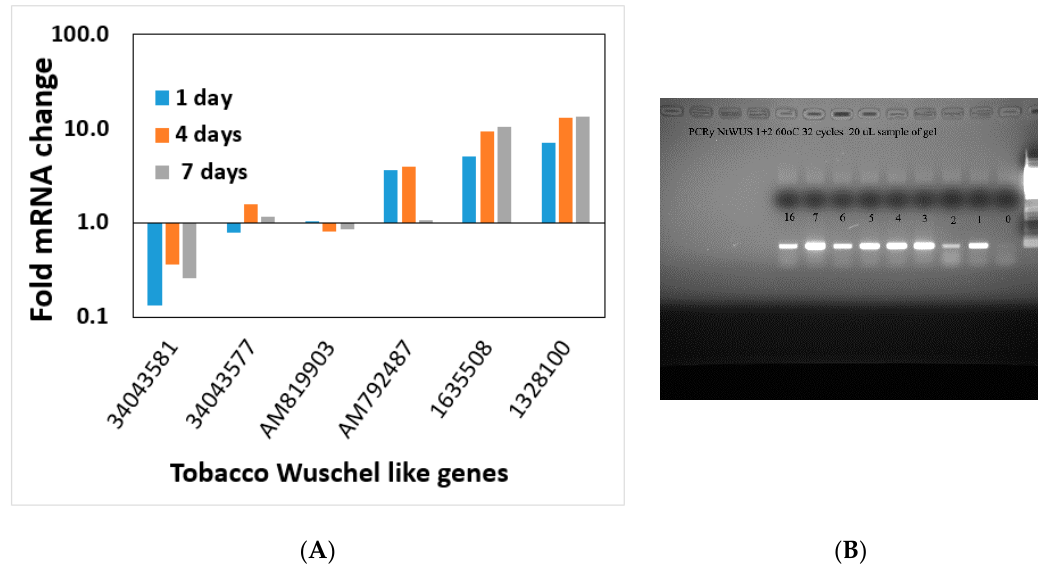
Figure 9. ( A ) Transcript pattern of Wuschel gene family (WOX) members during the induction period of shoot regeneration. The gene numbers are depicted on the x-axis. ( B ) Expression of NtWus during the shoot induction period on Reg medium.